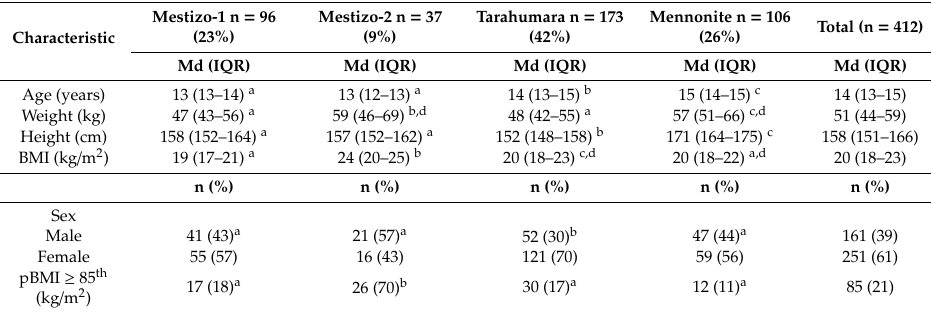
Table 1. General characteristics of studied populations.